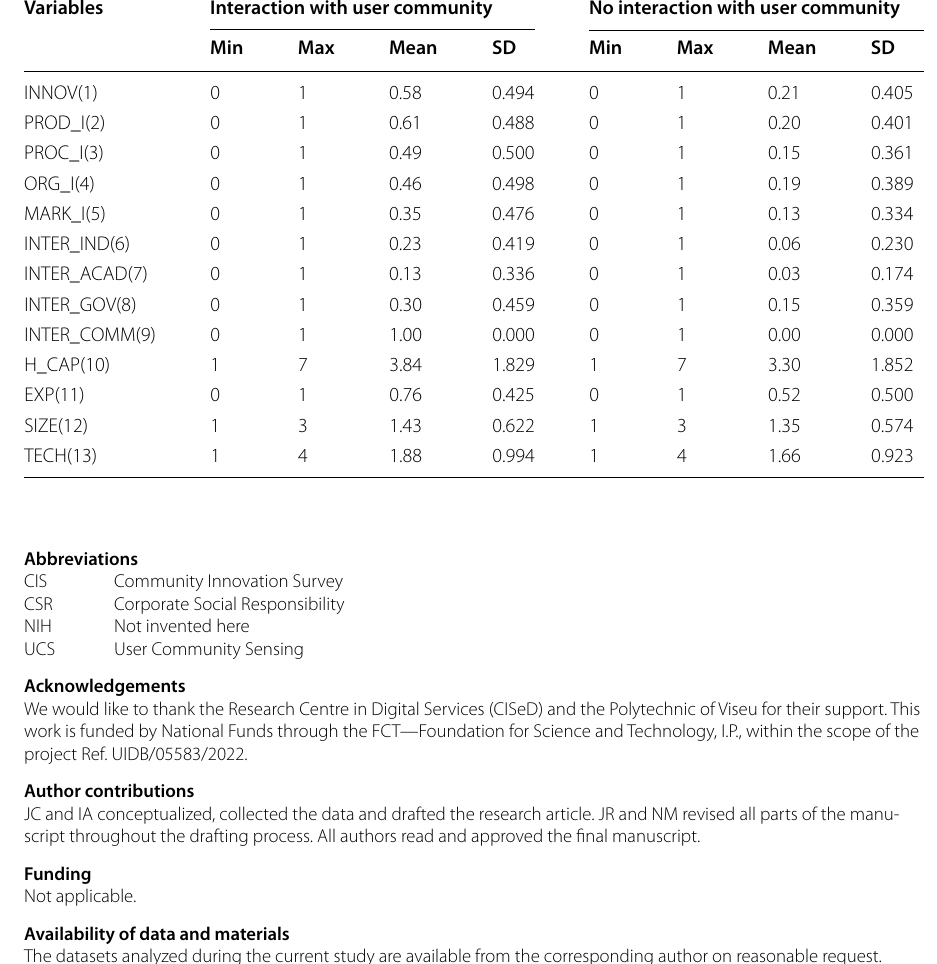
Table 13 Added value of interacting with user communities Variables Interaction with user community No interaction with user